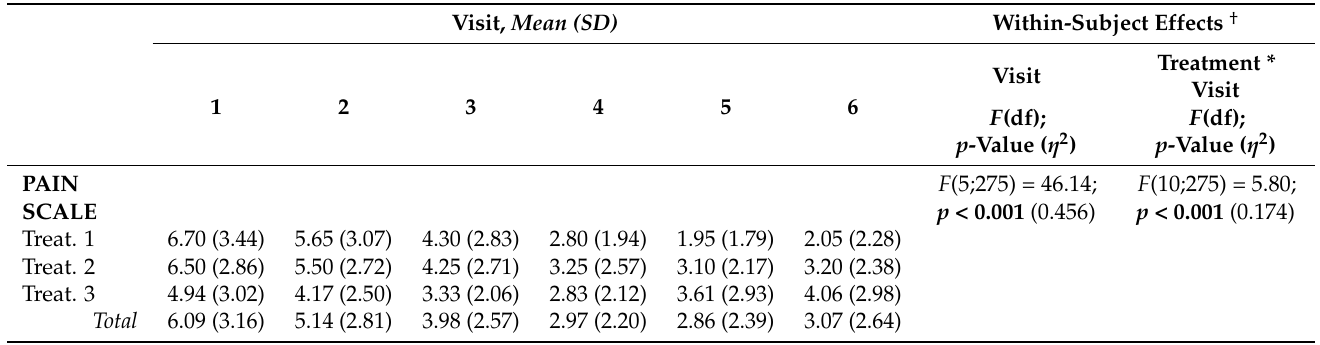
Table 2. Mean values (standard deviation SD) and statistical contrasts between pain treatments. Pain numerical rating scale score (Scale: